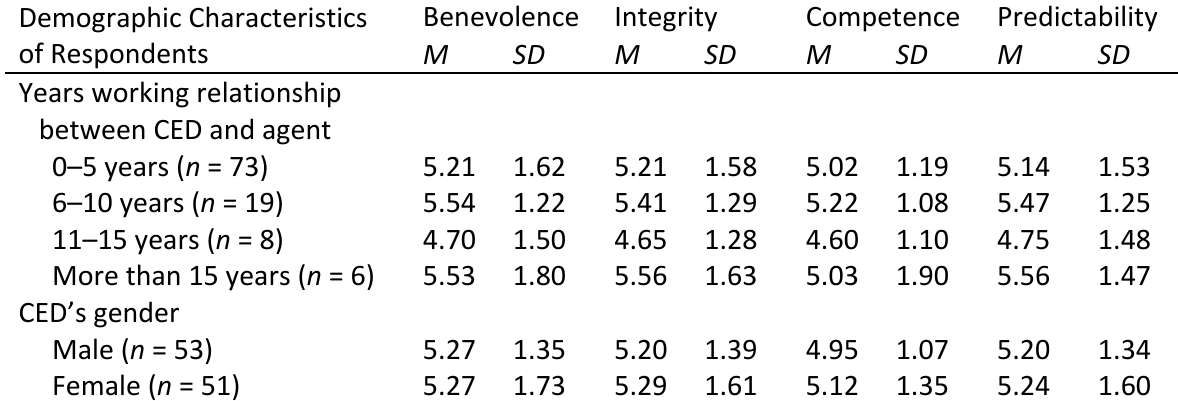
Index Means and Standard Deviations of CED Demographic Characteristics of Respondents and the TLS Antecedents Demographic